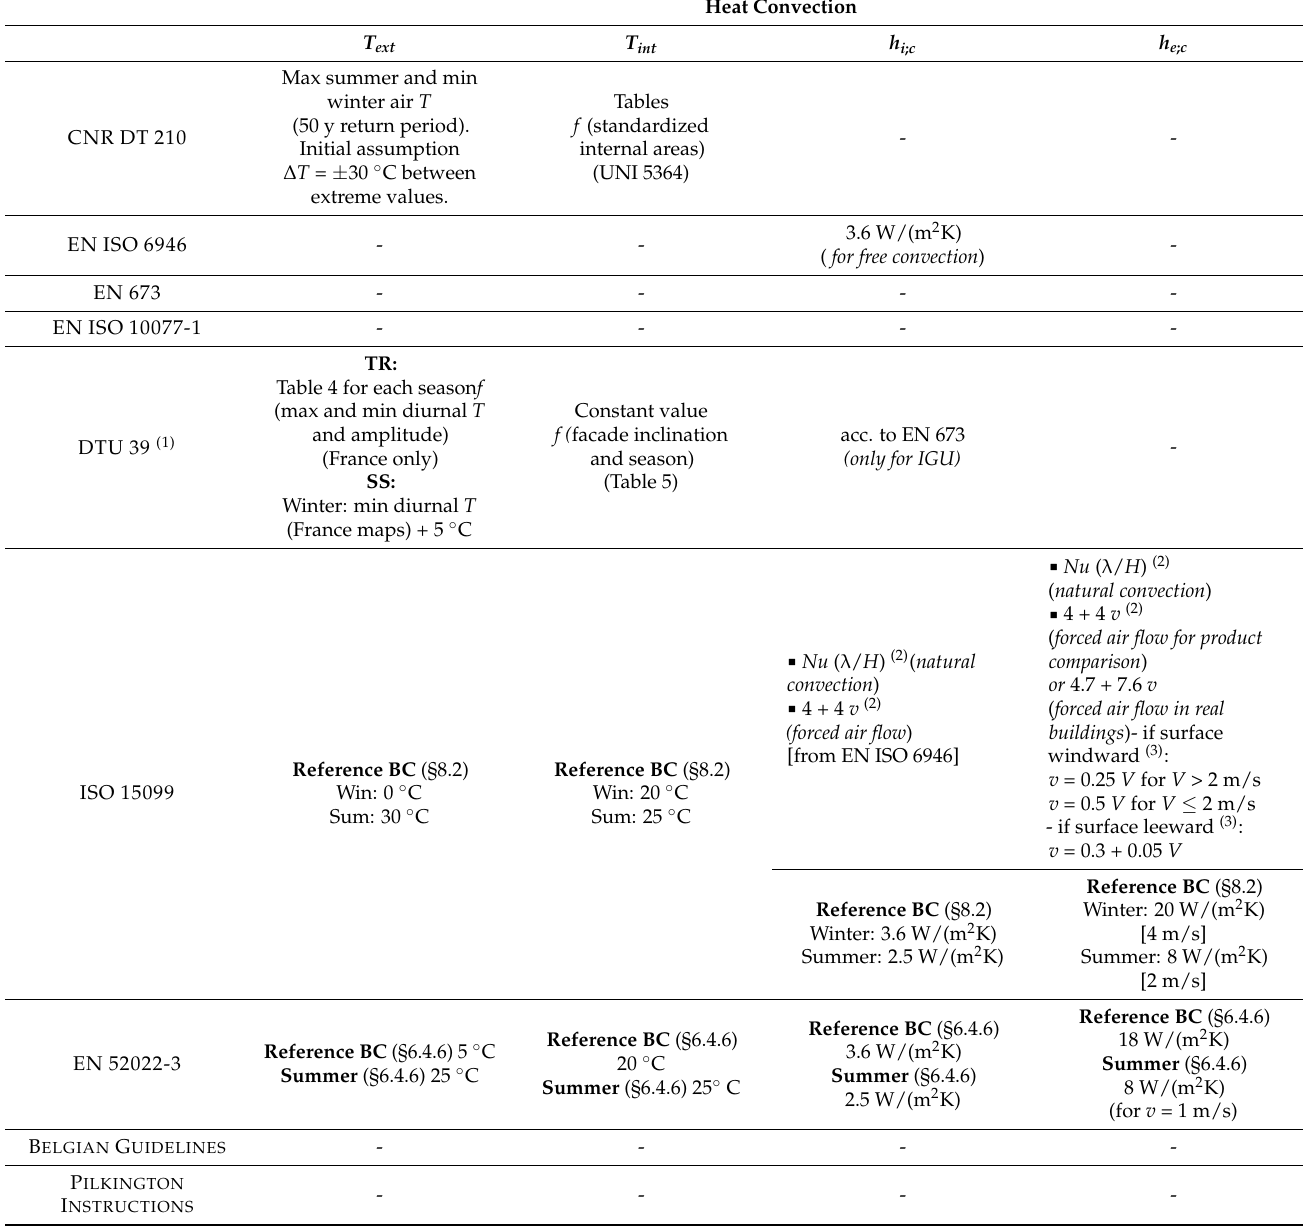
Table 2. Heat convection contributions according to different standards.